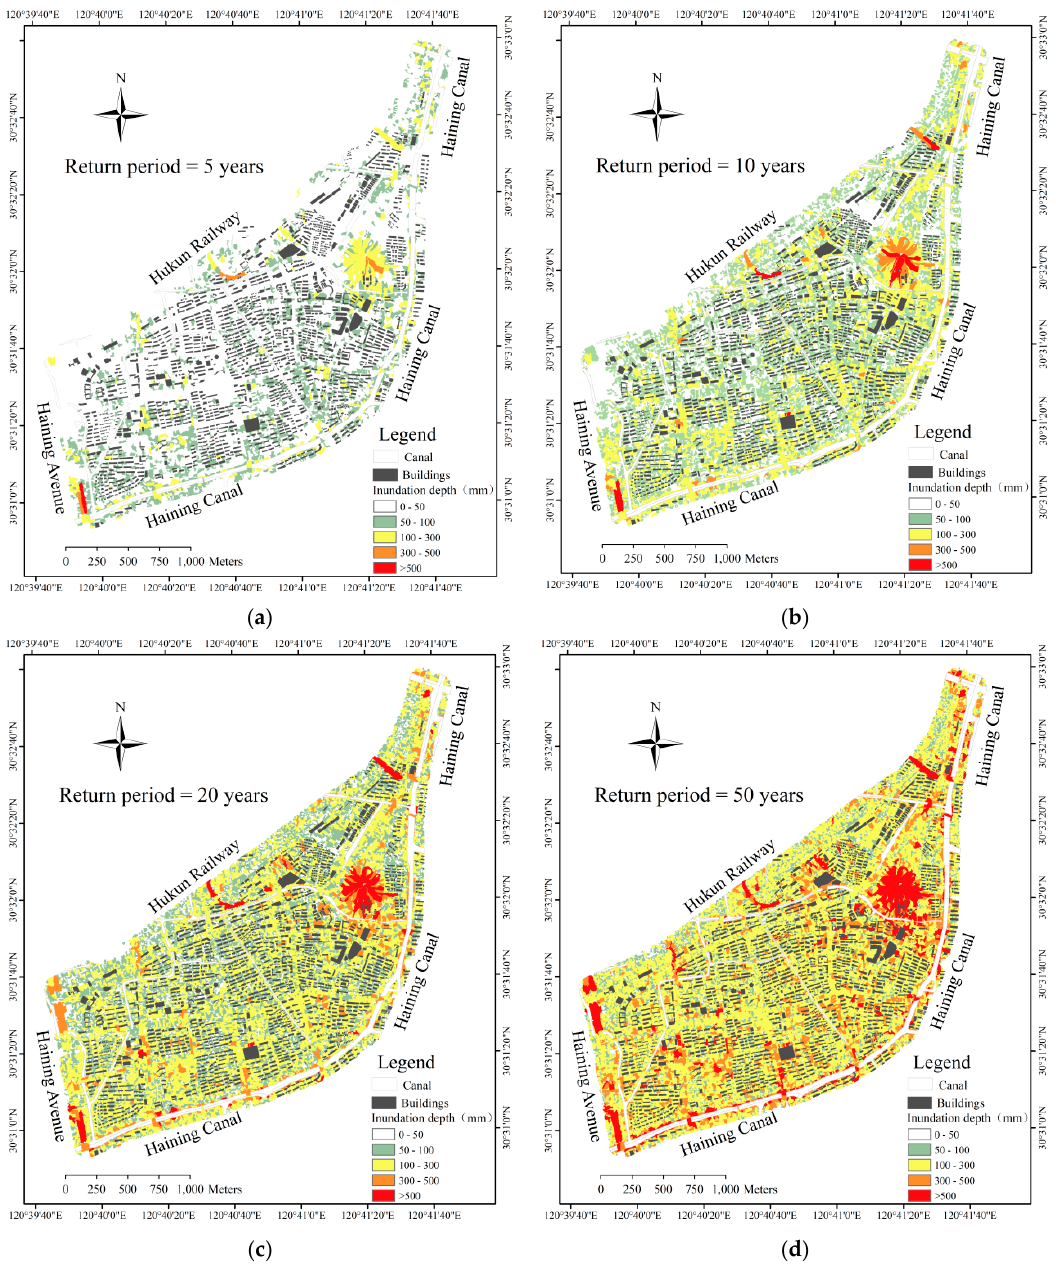
Figure 10. Projected inundation depths under four storm scenarios. ( a ) return period = 5 years; ( b ) return period = 10 years; ( c ) return period = 20 years; ( d ) return period = 50 years.